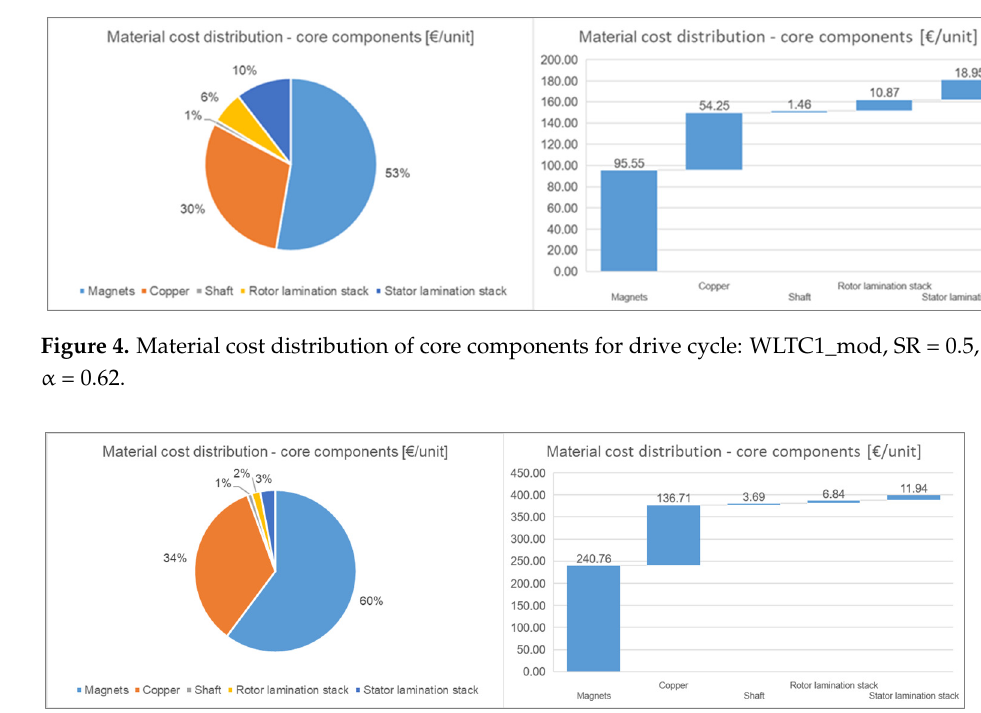
Figure 5. Material cost distribution of core components for drive cycle: WLTC1_SeLv, SR = 2.0, and